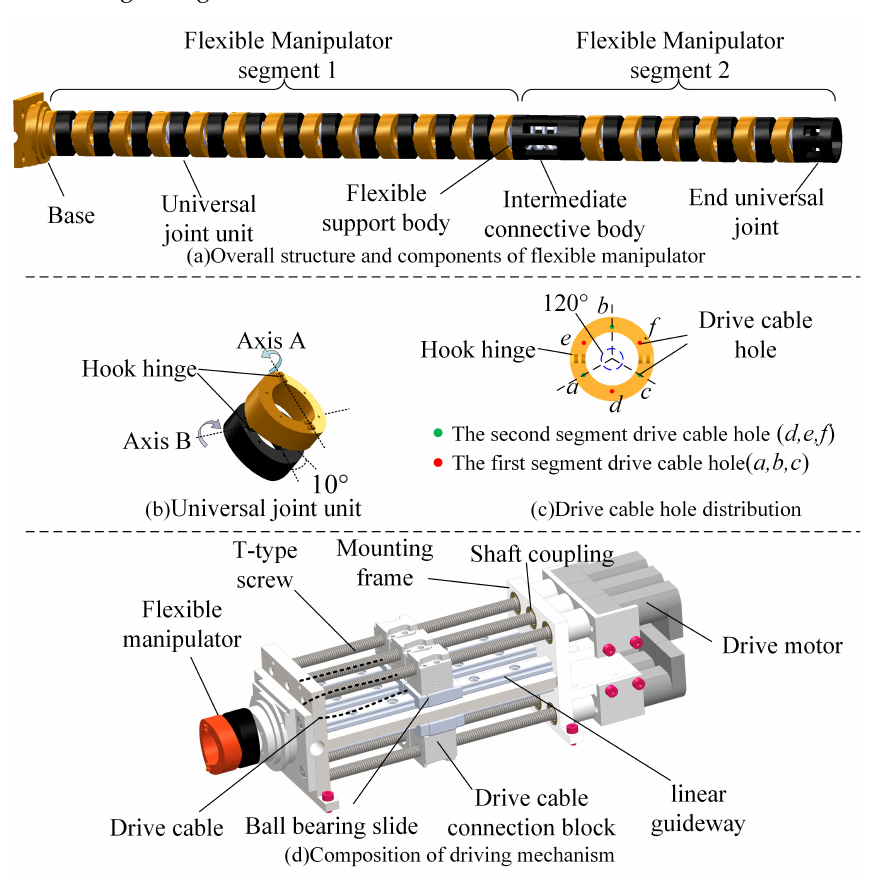
Figure 2. The structure of the flexible